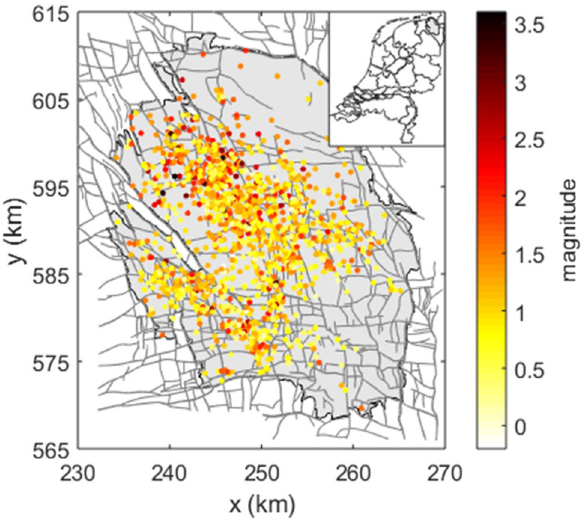
Figure 1. Overview of the epicentre locations of the Groningen induced seismicity for the period December 1991–November 16, 2021. The colours indicate the different local magnitudes of the